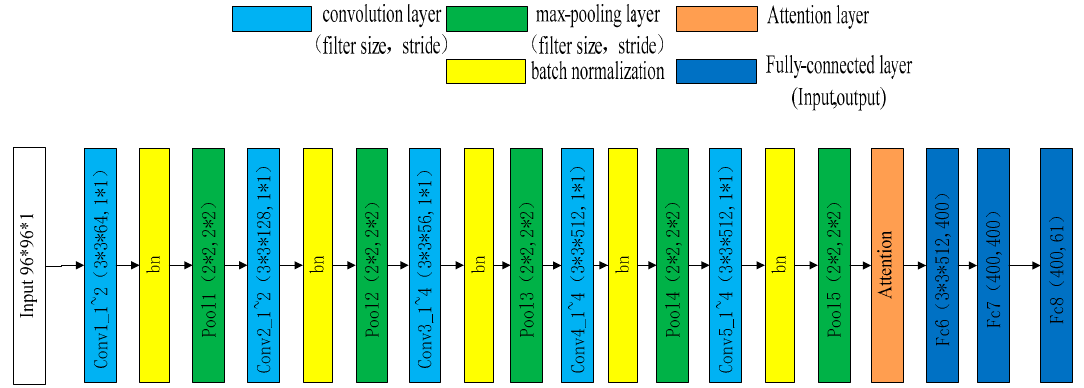
Figure 1. Structure of convolutional neural network3 (CNN3). Conv1_1~2 means conv1_1 and